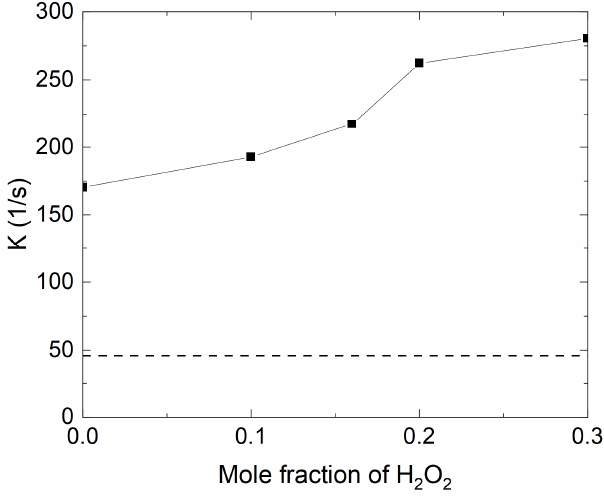
Figure 10. Computed strain rate at the location of maximum temperature (K) as a function of the H 2 O 2 mole fraction in the NH 3 /H 2 O 2 stream. A dashed line shows the prediction of Equation